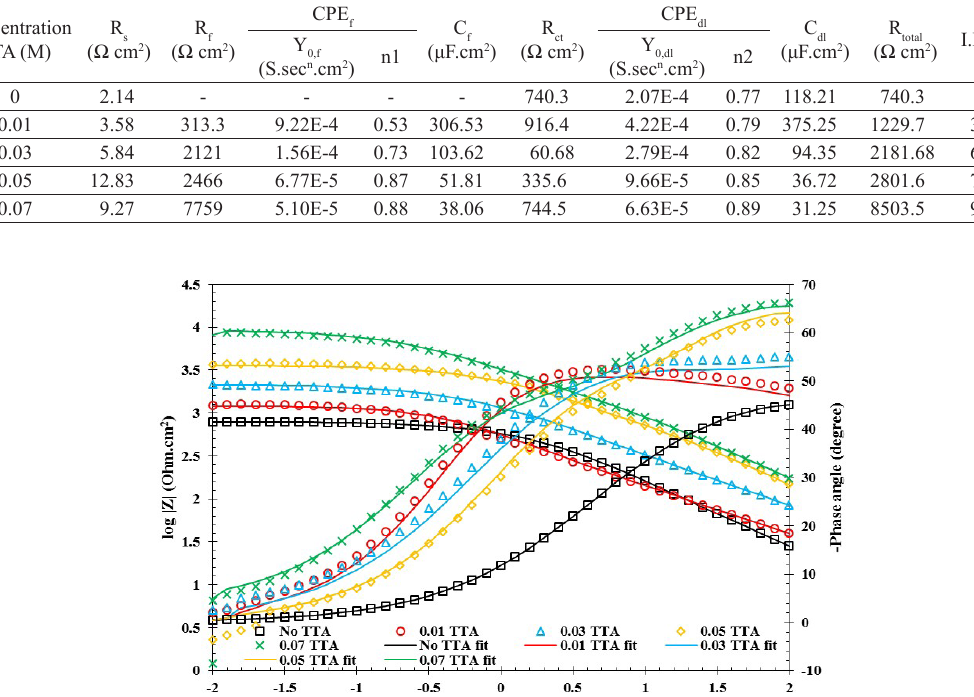
Table 5. Obtained results from the electrochemical modeling of the EIS experimental data on the suitable equivalent circuits. Concentration TTA